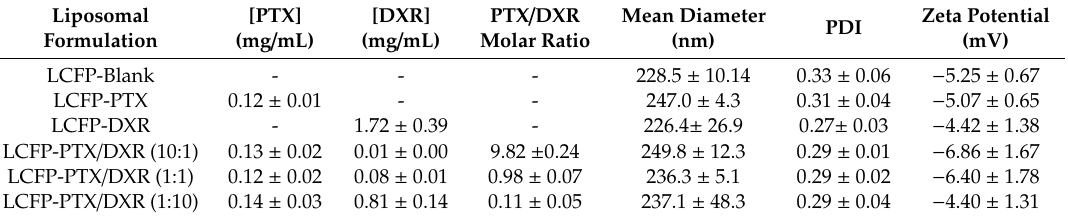
Table 1. Physicochemical characteristics of di ff erent liposomal